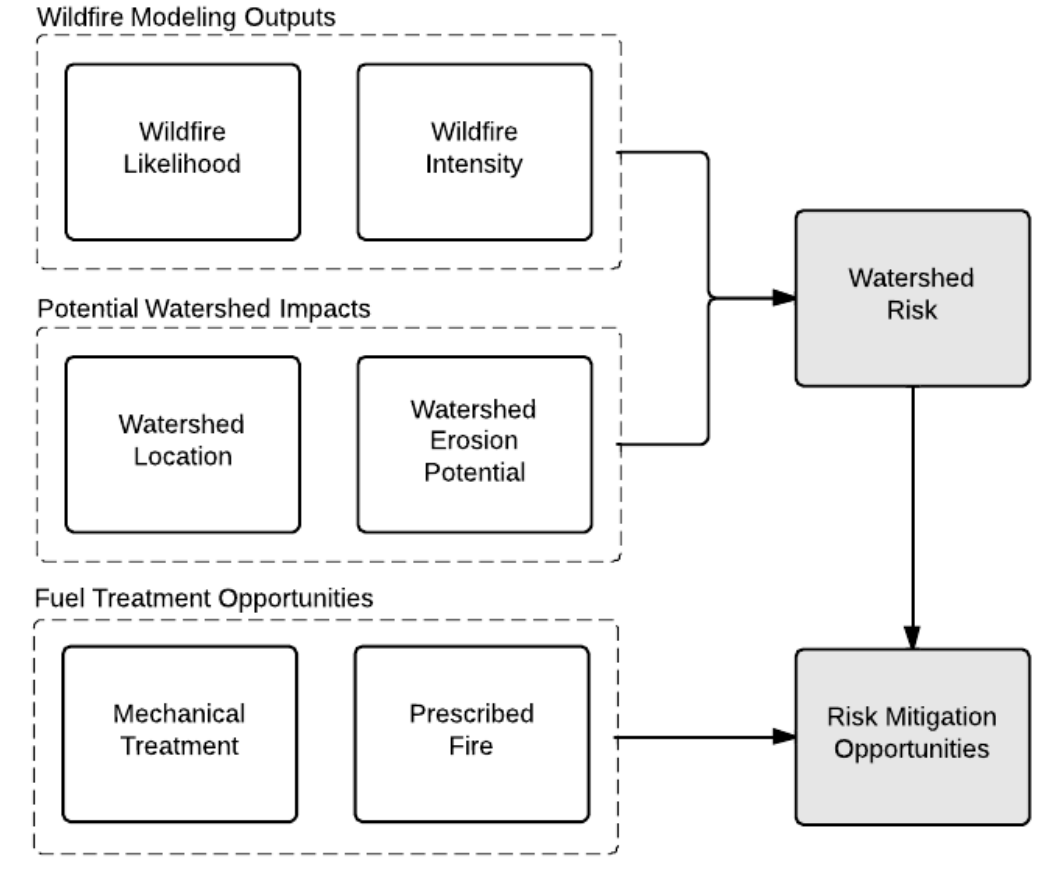
Figure 1. Conceptual model of primary components of wildfire risk and risk mitigation assessment